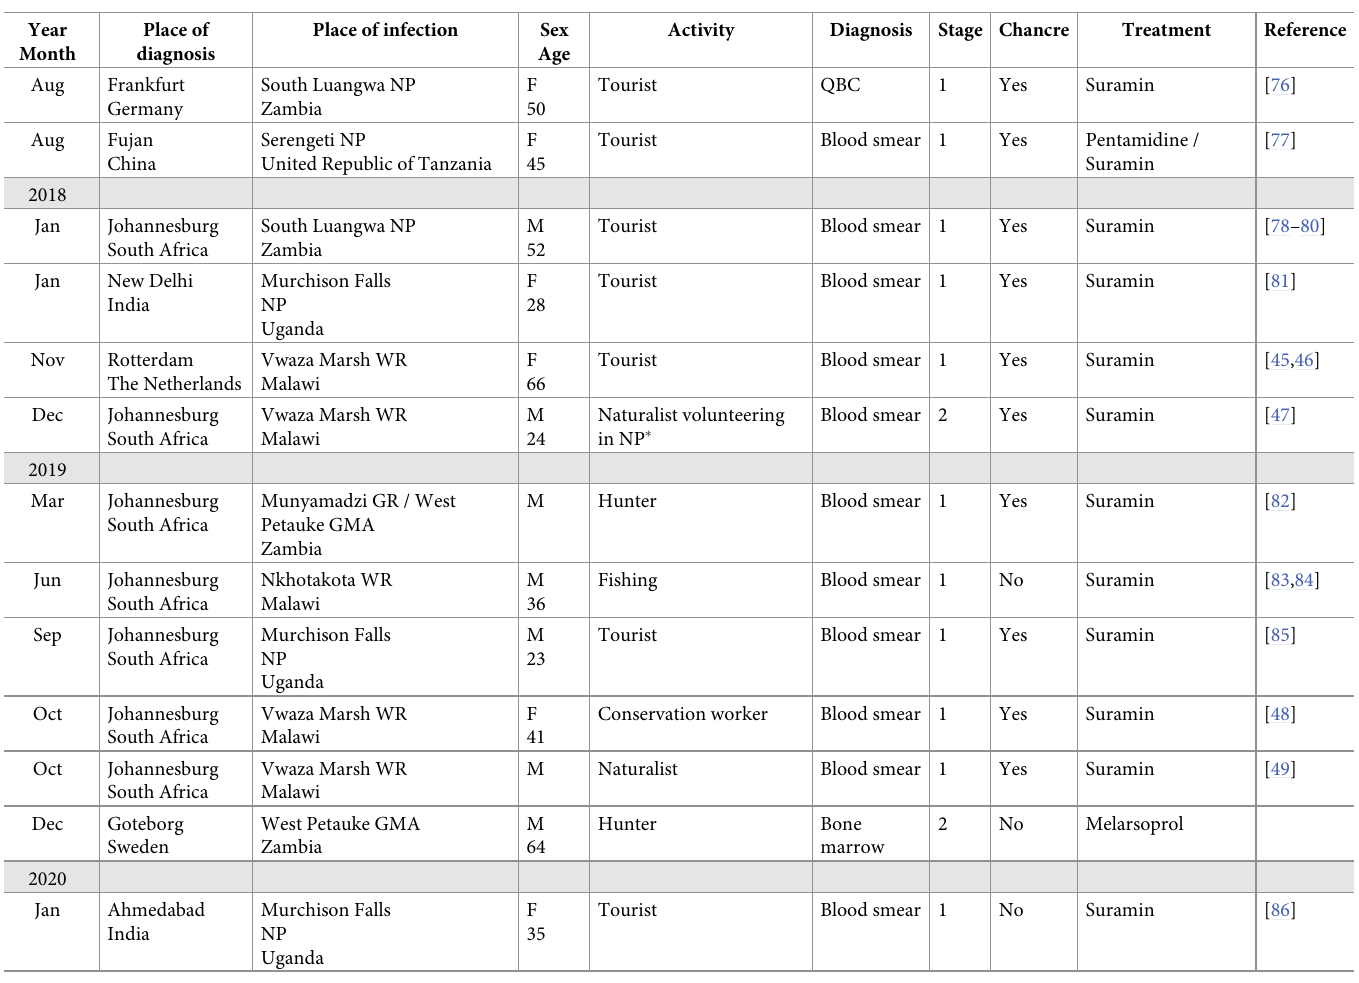
Some of these protected areas accounted for several cases, such as South Luangwa NP (4 cases), North Luangwa NP (2), Kasanka NP (2) and West Petauke GMA (2) in Zambia, Seren- geti NP in the United Republic of Tanzania (5), Murchison Falls NP in Uganda (5), Vwaza WR in Malawi (4) and Masai Mara NR in Kenya (2). The cases in Malawi were linked in time and space to a general outbreak of the disease [3]. For gambiense HAT, exported cases reported during the study period were infected in the Democratic Republic of the Congo (4), Gabon (3), Guinea (3), Cameroon (2), Angola (1) and Nigeria